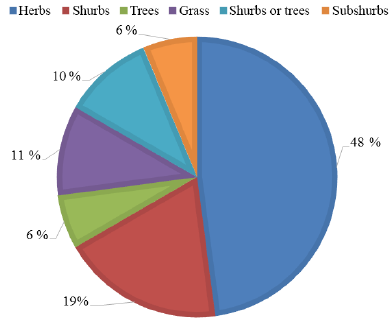
Figure 6. Plant growth forms in the study area.